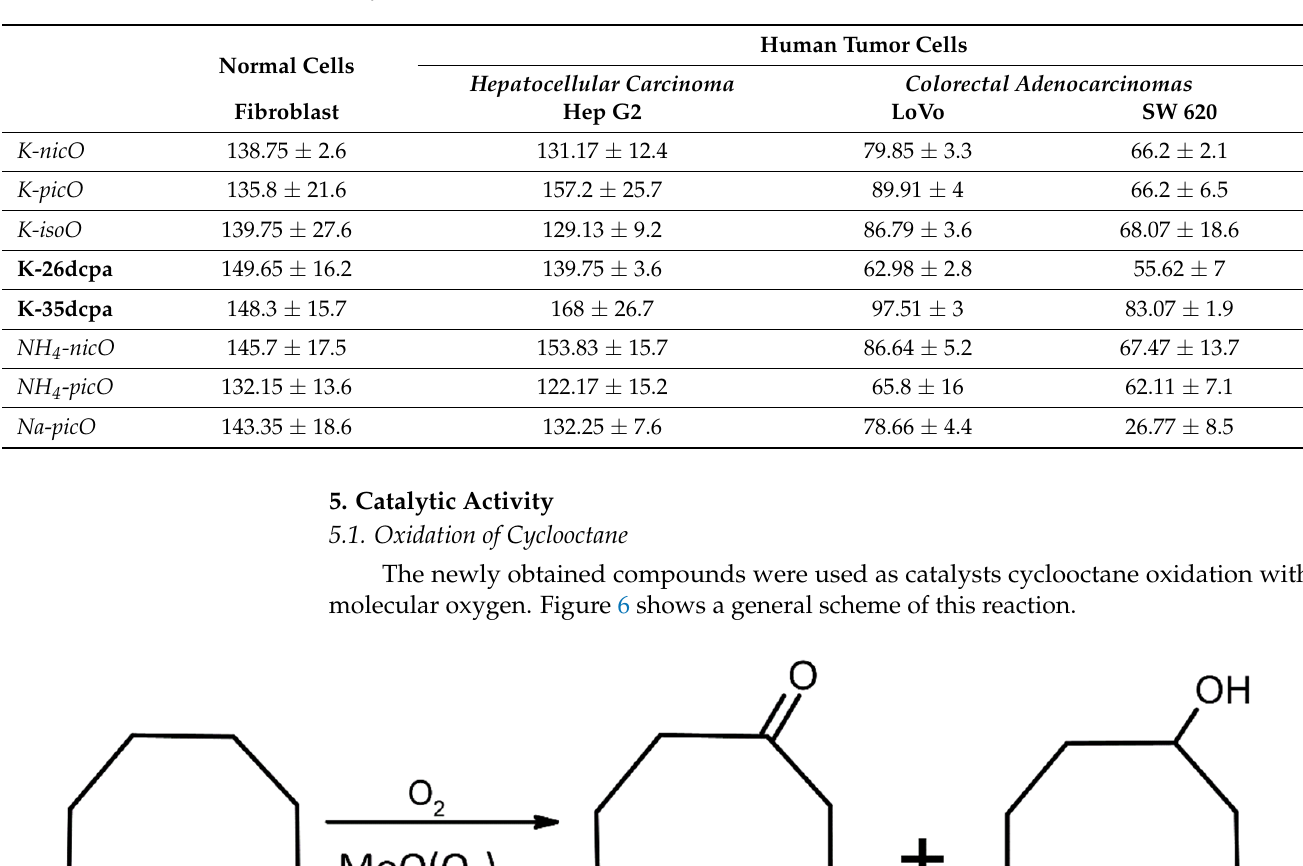
Table 5. IC 50 values [µM/L] of synthesized compounds at inhibiting the proliferation of normal human fibroblasts (BJ) and human tumor cells (Hep G2, SW 620, LoVo) as determined by the MTT assay. Results are means ± SD ( n = 3).